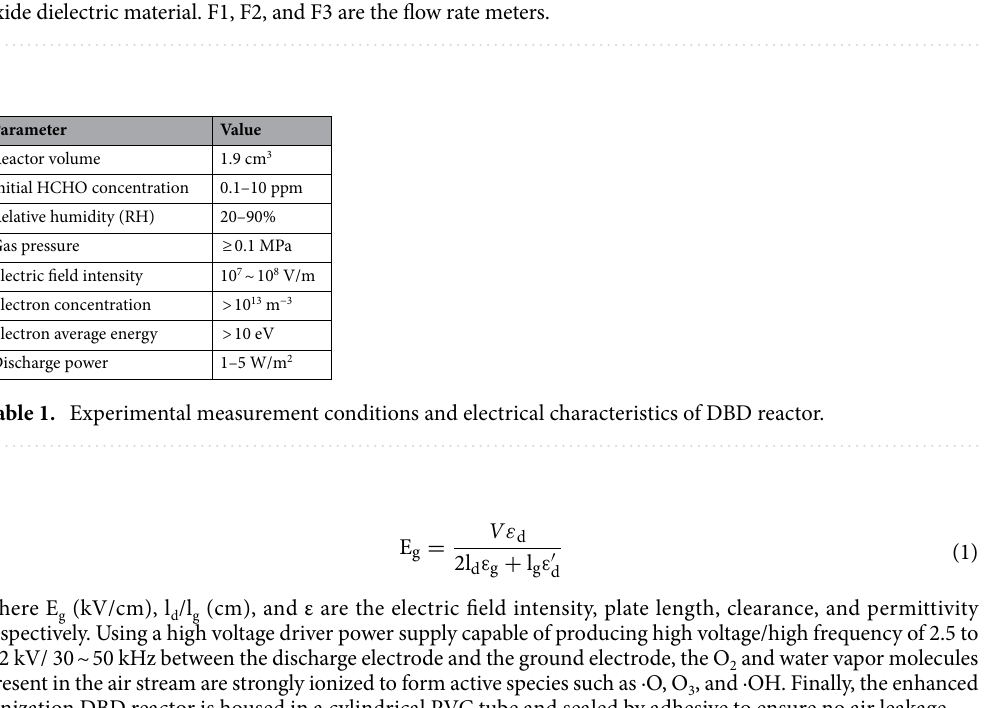
Figure 1. Schematic of the experimental setup. 1-dry air cylinder; 2-water-containing bubble tower, 3-HCHO- containing bubble tower, 4-oscilloscope, 5-monitor capacitor, 6-DBD reactor, 7-GC, 8-smart sensor humidity